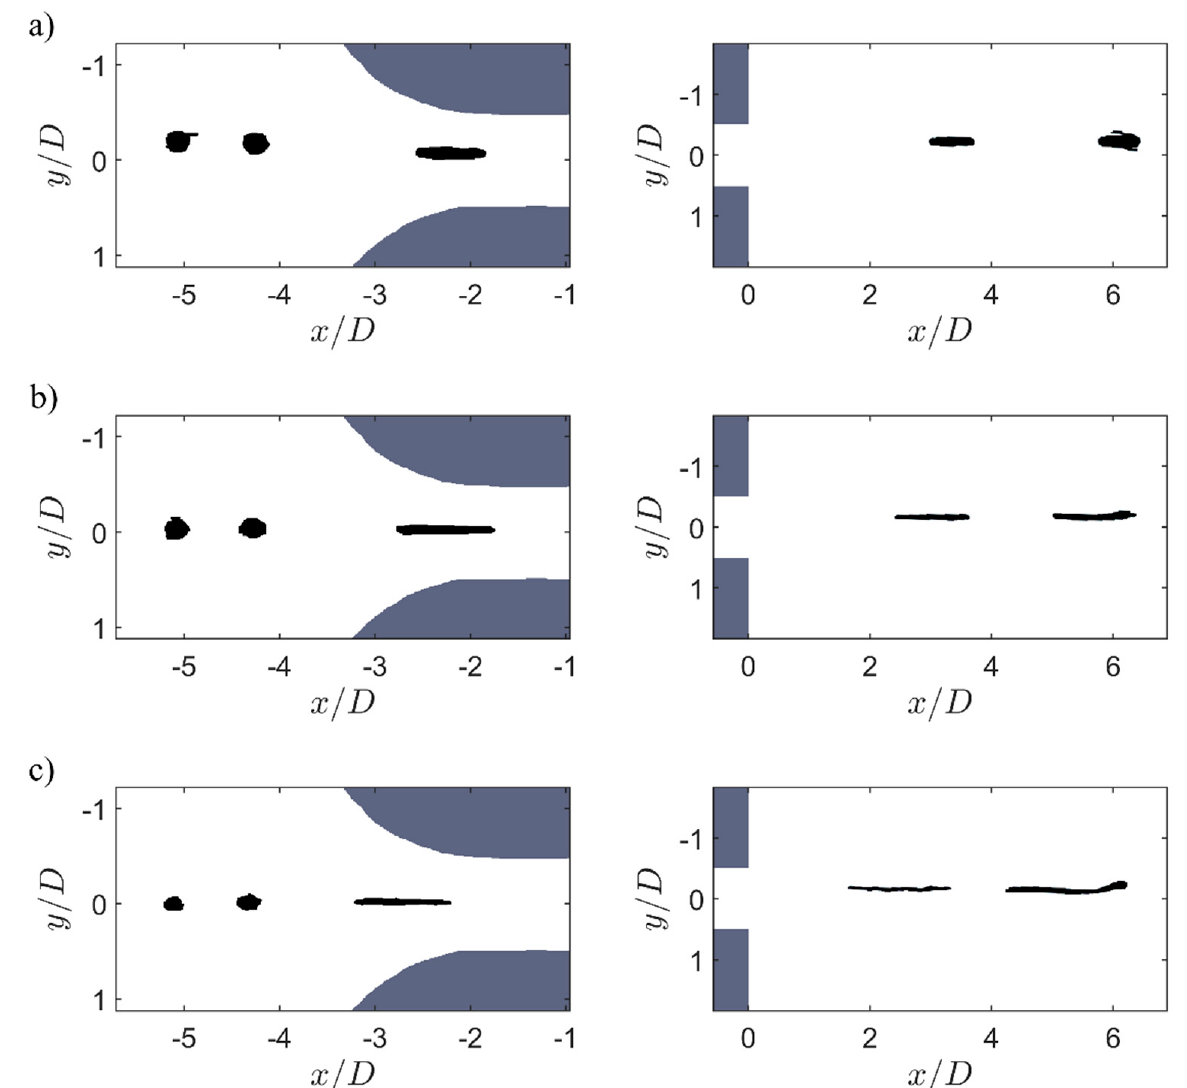
Figure 11. Temporal evolution of droplet deformations at different Reynolds numbers for the high viscous (viscosity ratio λ = 10.8): ( a ) Re = 2000, ( b ) Re = 4000 and ( c ) Re = 5700 .